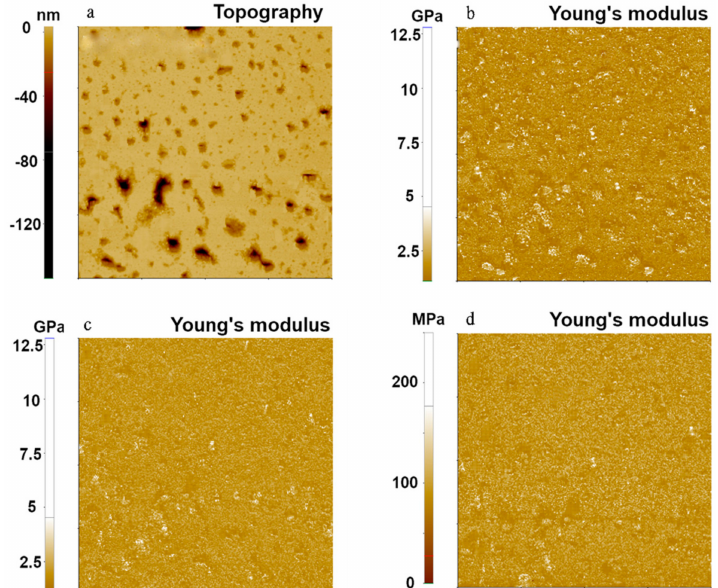
Figure 4. Topography ( a ) and Young’s modulus ( b – d ) images of PS using the PinPoint TM nanome- chanical mode. These Young’s modulus images were obtained using Hertzian ( b ), DMT ( c ), and JKR ( d ) models. The scan size of all images was 10 µ m × 10 µ